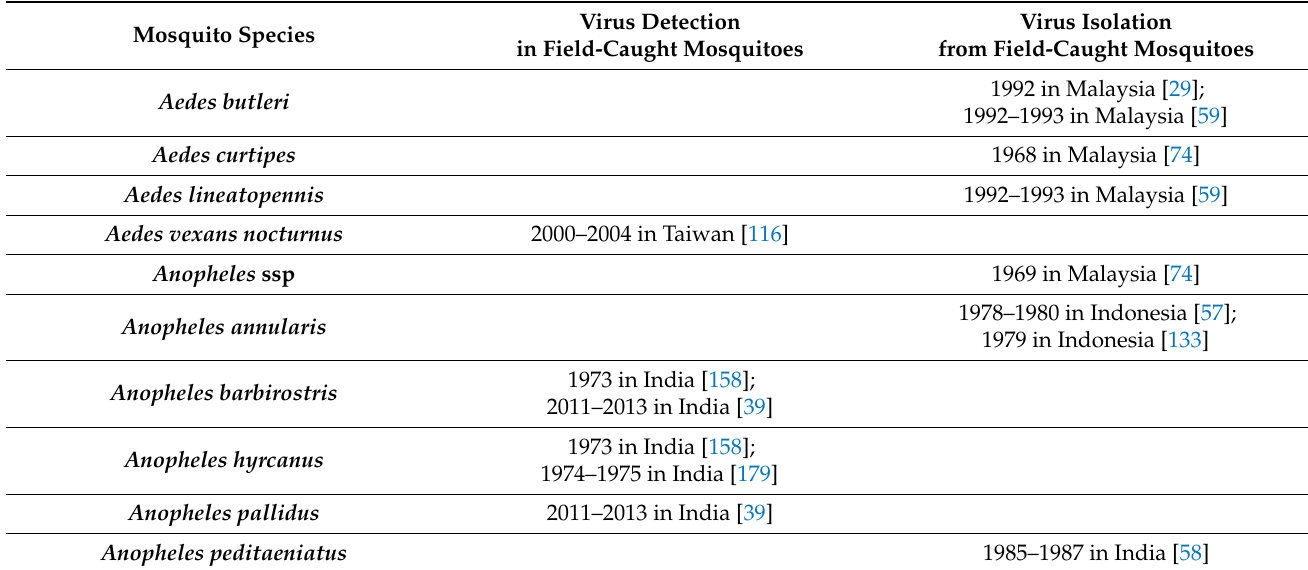
Table 2. Mosquito species with evidence for JEV from field-caught